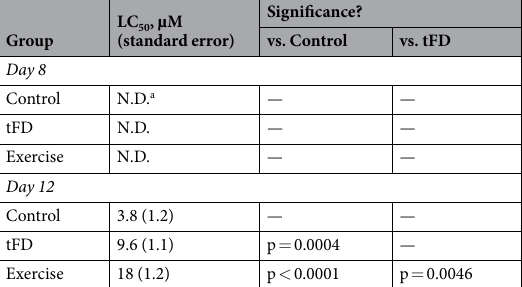
exercise, respectively. Pairwise comparison of groups revealed no significant difference between control and tFD (p = 0.37, Mantel-Cox test), potentially due to high variability in the tFD group. However, we observed signifi- cant differences between the exercise group as compared to both control (p = 0.0020, Mantel-Cox test) and tFD (p < 0.0001, Mantel-Cox test). Therefore, regular exercise throughout the adult reproductive period was associ- ated with a modest increase in lifespan. As a complementary approach to the lifespan analysis, we measured a proxy of declining health – autofluores- cence, which is reported to increase as nematodes age 21,22 . Blue autofluorescence arises from accumulation of anthra- nilate and indicates that animals are near death 21,34 . We observed increased blue autofluorescence in both the control and tFD groups on day 12 compared to the exercise group (Fig. 6b), suggesting that as a population, more animals were near death in the control groups compared to the exercise group, which is consistent with the lifespan analysis. Red autofluorescence also changes with age and is reported to correlate with healthspan 21,22 . We observed complex patterns of red fluorescence change in the control and tFD groups (Supplementary Fig. S6A), but sig- nals from the exercise group were higher than the tFD group on both day 8 and day 12, suggesting differences in post-reproductive exercised animals that may be attributed to the training experience and, contrary to age-related pigment accumulation, might be interpreted as stronger health. Further studies are needed to identify the pig- ment that fluoresces in the red wavelengths and determine how it could be impacted by food restriction and exercise conditioning. Exercise conditioning in food-containing media confers some, but not all, protections observed from exercise in the absence of food. While it was clear that transient food deprivation and exercise resulted in significant protection to age- and chemical-induced mitochondrial damage, we could not tell if these interventions were working through similar or different mechanisms. For example, it is possible that the